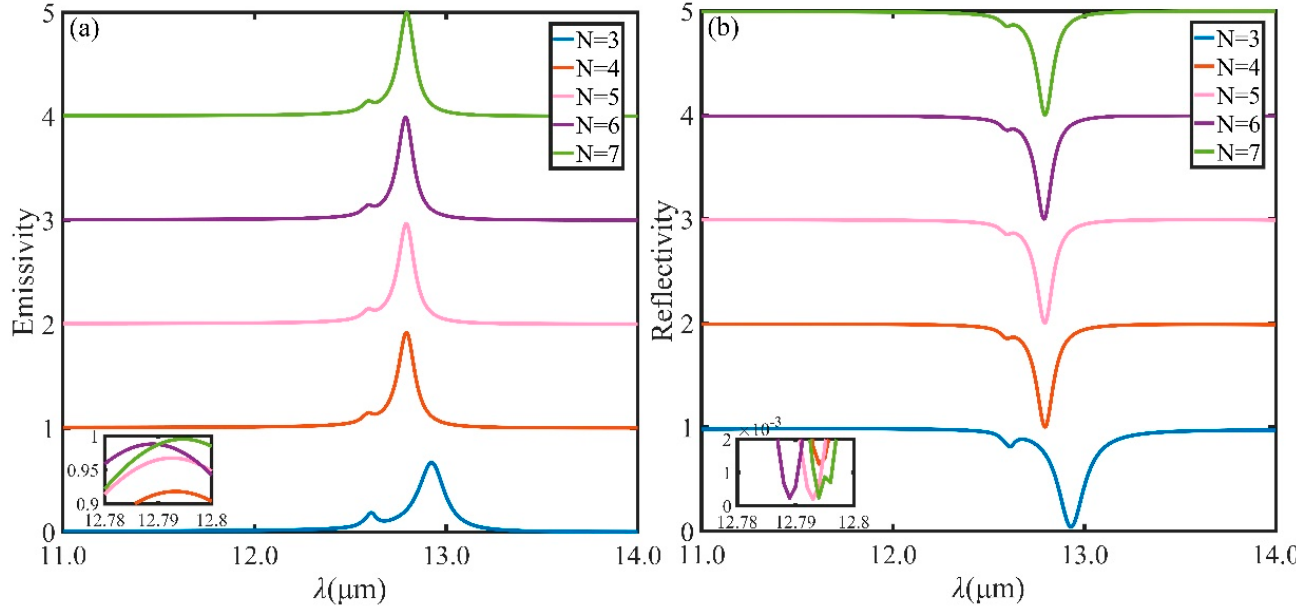
Figure 2. ( a ) Emissivity at normal incidence for TM polarization with different number of distributed Bragg reflector (DBR) pairs ( N ). ( b ) Reflectivity at normal incidence for TM polarization with different number of distributed Bragg reflector (DBR) pairs ( N ). The other parameters are chosen as t = 0.45 µ m, d s = 0.75 µ m, d 1 = 1.25 µ m and d 2 = 0.75 µ m. The function of Ge spacer layer is equivalent to an optical cavity in the multilayer structure. The emissivity as a function of wavelength and d s is plotted in contour Figure 3, the emission can be significantly changed by adjusting d s . A splitting effect can be observed, and perfect absorption is achieved with d s = 0.75 µ m. The coupling between the TPhPs and cavity modes has been tuned by varying d s . At different values of d s , there is an anticrossing between the two modes, leading to different Rabi-like splitting values for the